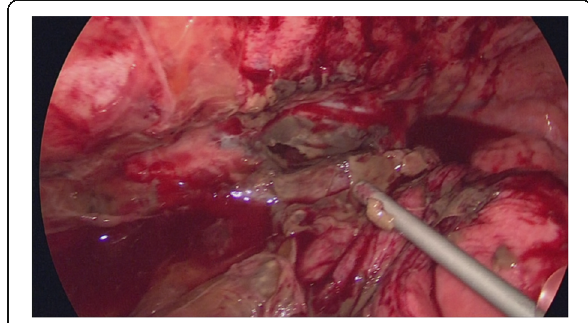
Fig. 3 Findings of emergency thoracoscopy. Emergency thoracoscopy revealed necrosis and perforation of the esophagus